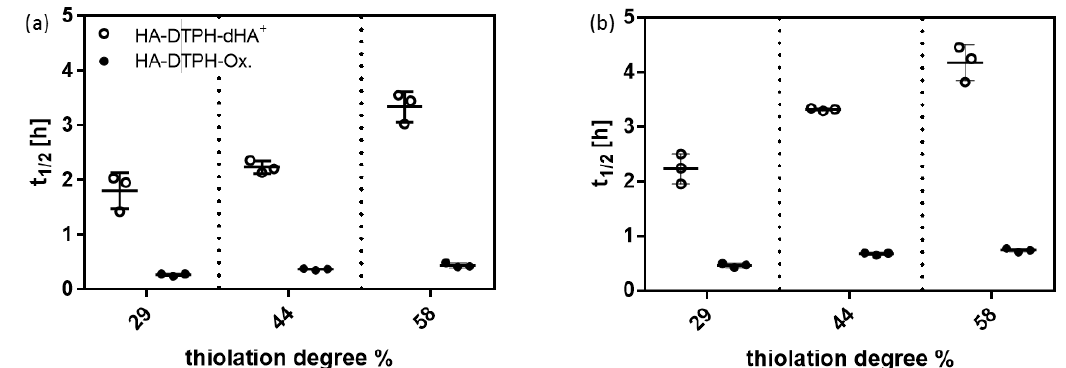
Figure 5. Enzymatic degradation of HA-DTPH-dHA + and HA-DTPH-Ox. ( a ) in 100 U/mL hyaluronate lyase in PBS and ( b ) in 100 U/mL hyaluronidase in PBS.